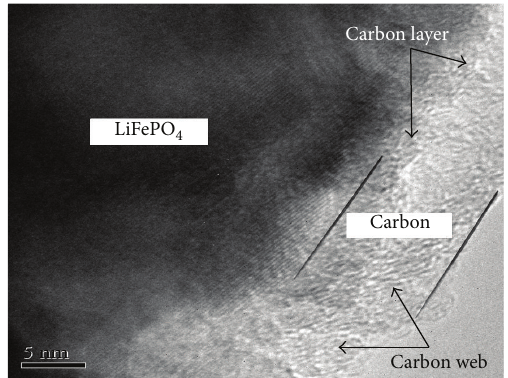
Figure 3: TEM image of spherical LiFePO 4 /C synthesized from nanosized spherical FePO 4 ⋅ 2H 2